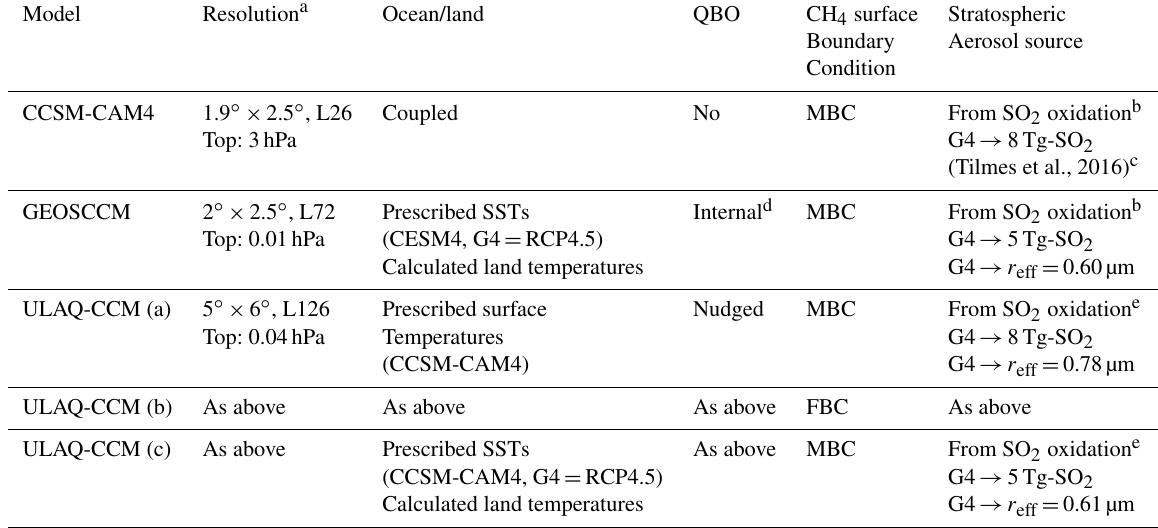
Table 1. Summary of main model features. The sixth column includes the stratospheric aerosol effective radius ( r eff in µm) at 20km over the tropics (2040–2049). Values deduced from SAGE-II observations are 0.22µm ( σ = 0.02µm) as an average over 1999–2000 for unperturbed background conditions and 0.57µm ( σ = 0.03µm) as an average over July 1992–June 1993 for a volcanic perturbation (i.e., Pinatubo) comparable in magnitude to G4 with 5Tg-SO 2 injection (in terms of average stratospheric mass burden of sulfate). G4 aerosols are injected at the Equator between 16 and 25km altitude (uniformly) for GEOSCCM and between 18 and 25km (Gaussian distribution) for ULAQ- CCM. MBC indicates the mixing ratio boundary condition and FBC indicates flux boundary condition. Model Resolution a Ocean/land QBO CH 4 surface